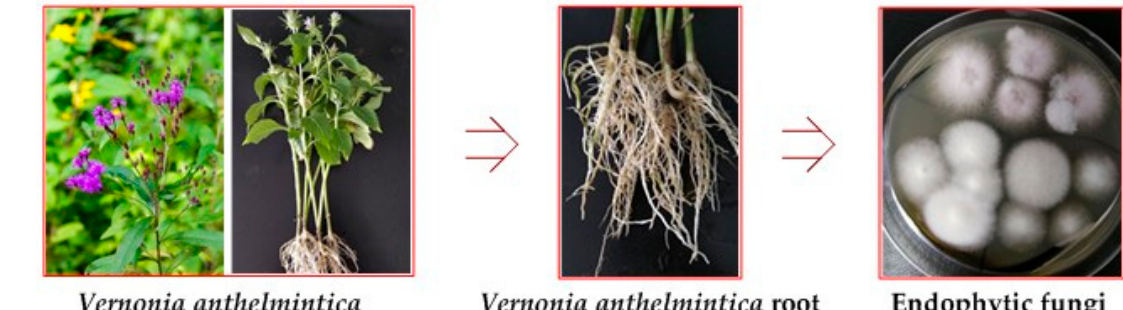
Figure 1. Main approach used in the present study.